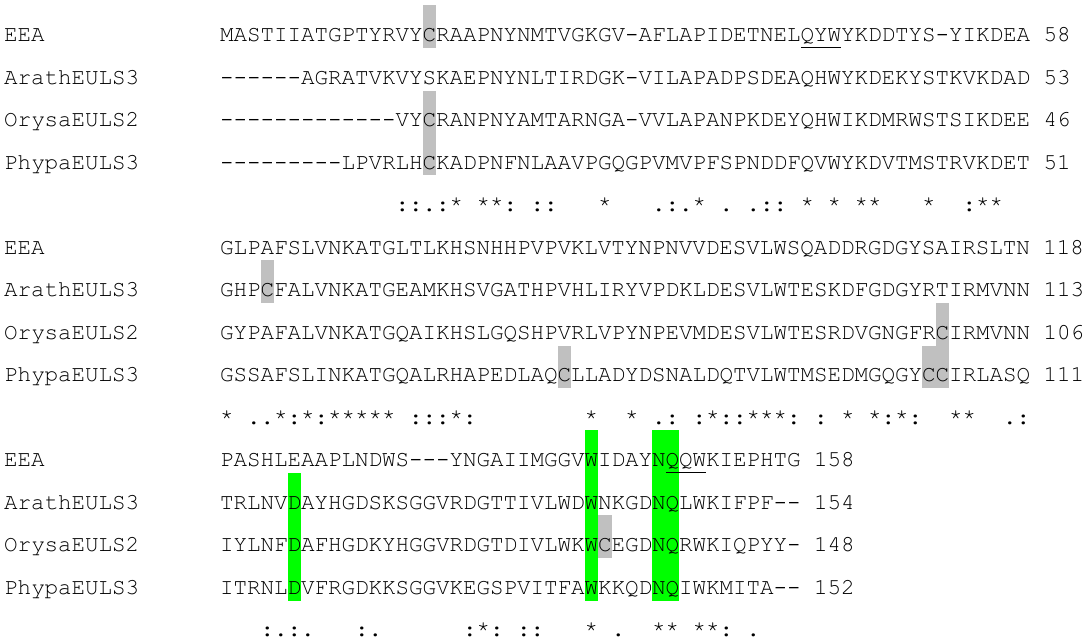
Figure 2. Sequence alignment of the amino acid sequences encoding the EUL domains from Euonymus europaeus (EEA), Arabidopsis thaliana (ArathEULS3), Oryza sativa (OrysaEULS2) and Physcomitrella patens (PhypaEULS3). Identical residues are indicated by asterisks and similar residues by dashes or colons. The amino acids that form the putative carbohydrate-binding site are shaded green. The cysteine residues are indicated in grey. The QXW motifs are underlined in the EEA